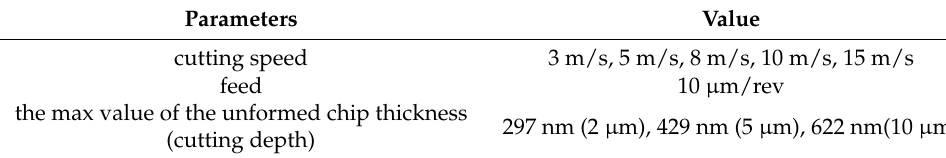
Table 5. Experimental design parameters.